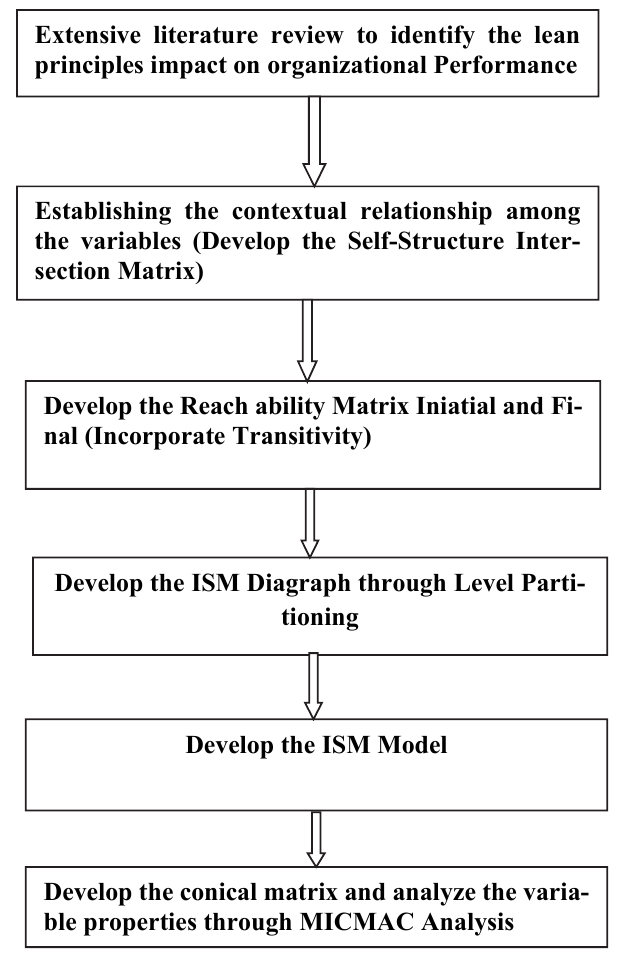
Fig. 2. Flow Chart for Present Study (Source: Luthra et al., 2011 (Modified)) Step 2: Development of contextual relationship among